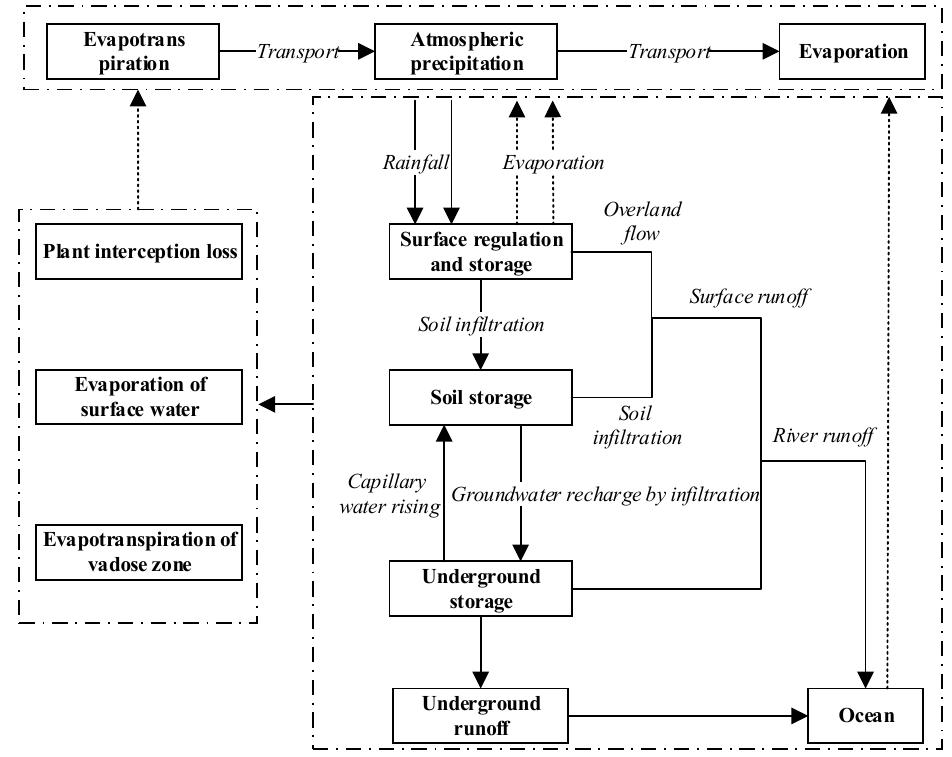
Figure 1. Schematic diagram of the natural water circulation